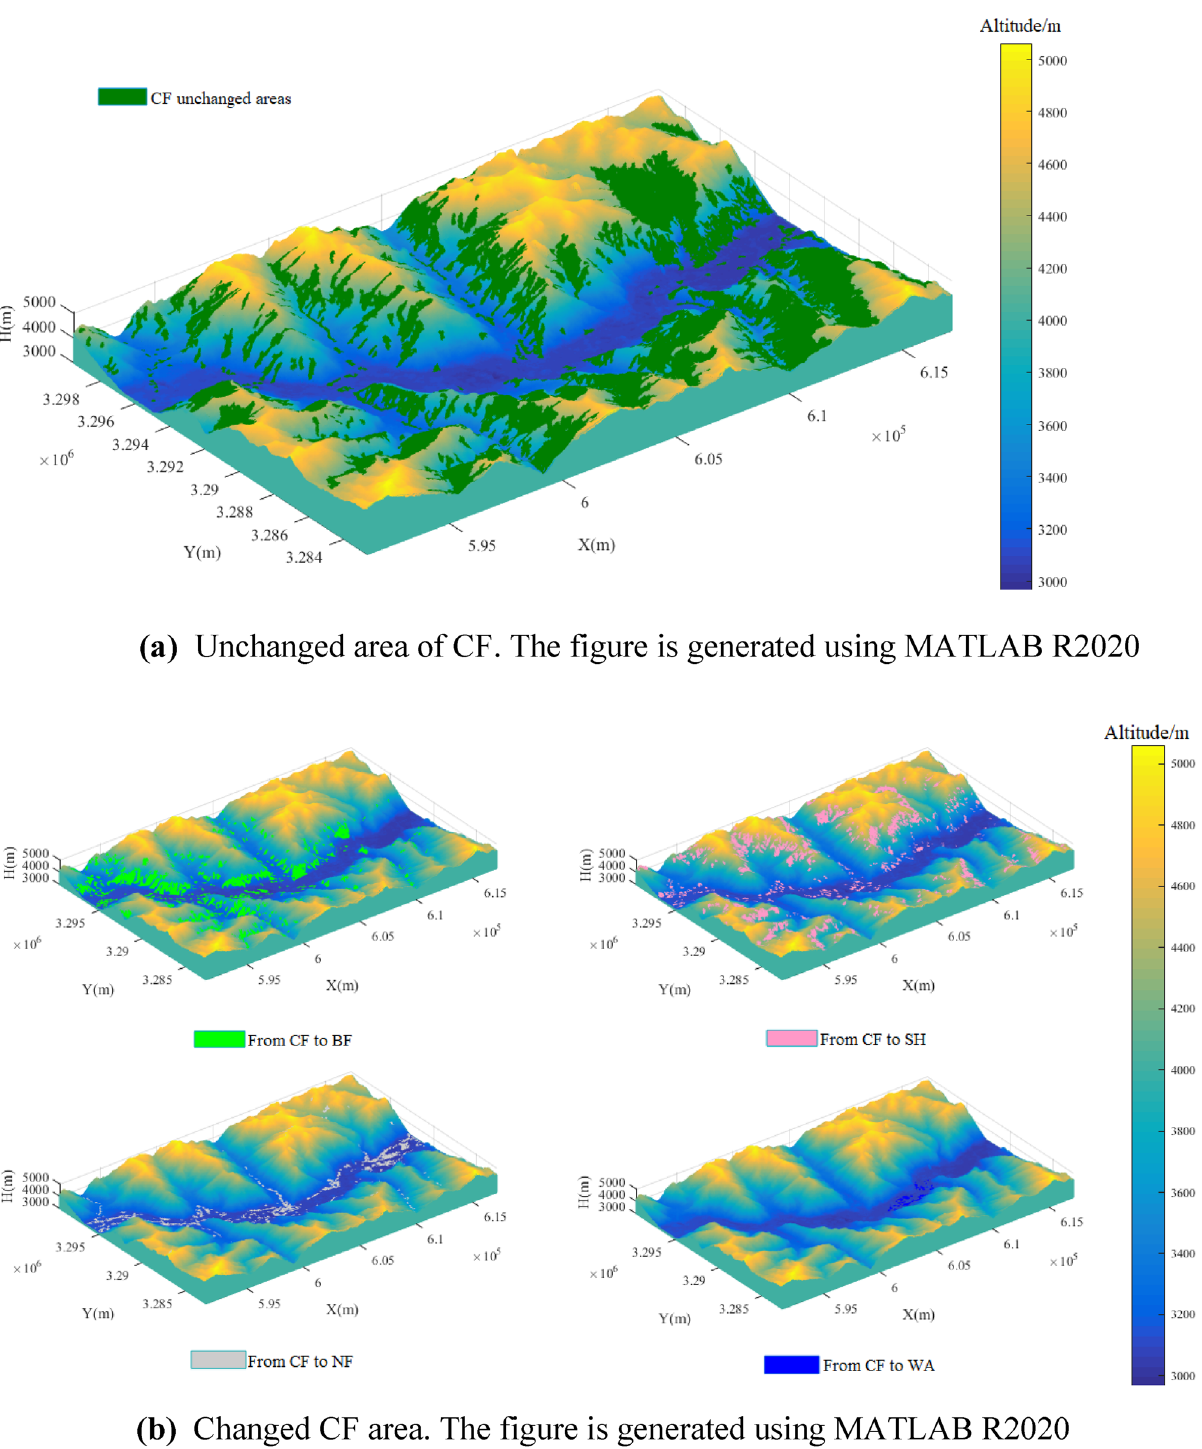
Figure 5. (a) Unchanged area of CF. The figure is generated using MATLAB R2020 (http:// www. mathw orks. com). (b) Changed CF area. The figure is generated using MATLAB R2020 (http:// www. mathw orks.